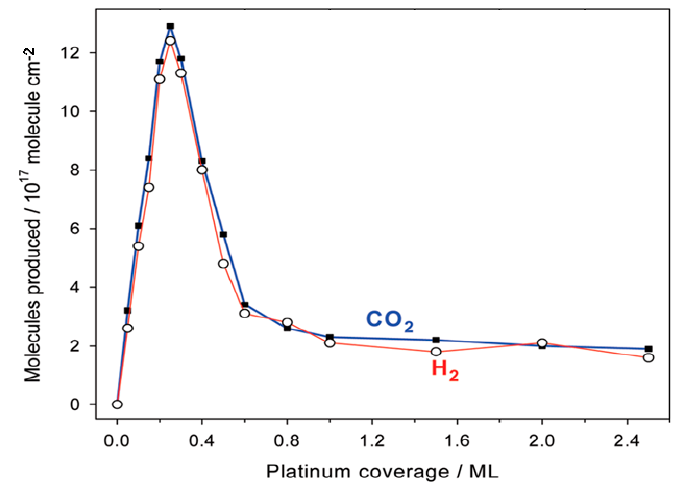
Figure 24. WGS activities of model Pt/CeO 2 (111) catalysts as function of admetal coverage (CO/H 2 O = 2, T = 352 °C), adapted from [182], with permission from America Chemical Society, 2012.